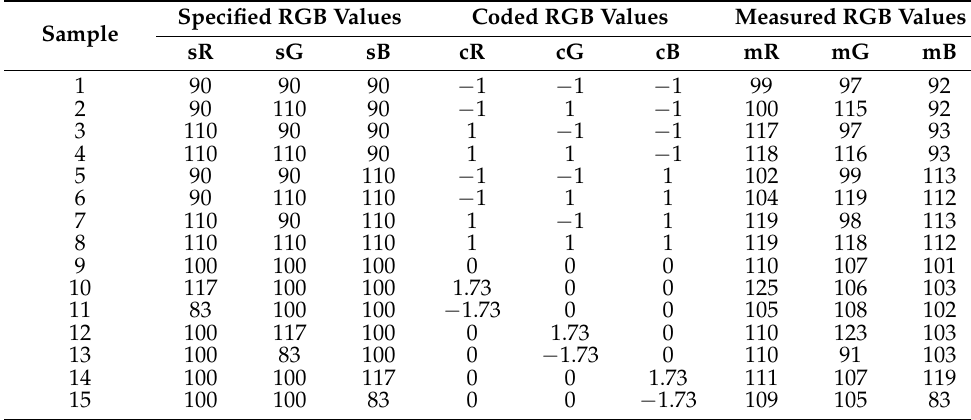
Table A1. CCD matrix and results for Case 1.